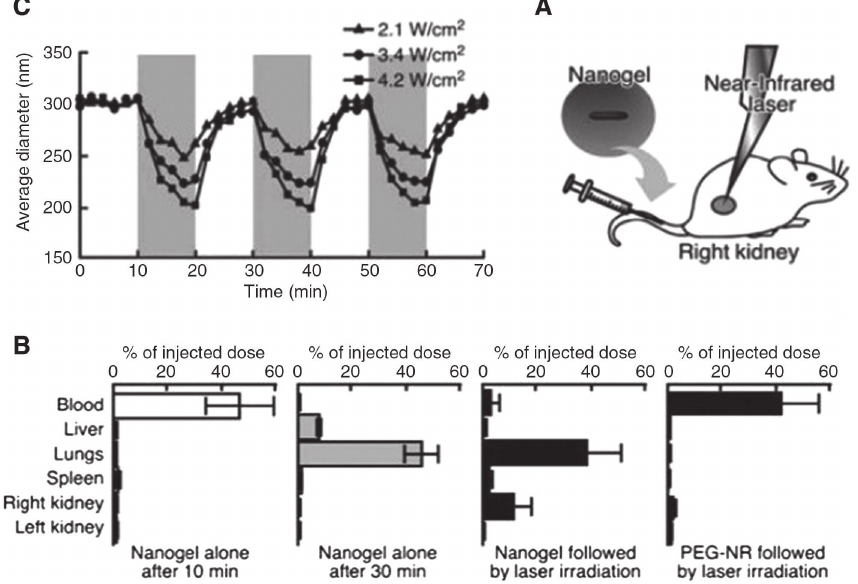
Figure 10: (A) A scheme showing the administration of the gold-hydrogel particle nanocomposites followed by near-IR light irradiation. (B) White and light-gray bars indicate the distribution after 10 and 30 min, respectively, when particle nanocomposites were injected with no irradiation. The black bars indicate the distribution when nanocomposites are injected followed by laser irradiation. The last dia- gram indicates the injection of polyethylene glycol (PEG)-modified gold nanorods and laser irradiation. (C) The hydrodynamic diameters of PNIPAAm-coated gold nanorods upon irradiation using a near-IR laser with increasing power density. The periods of laser irradiation are indicated by the gray area. Reproduced from Ref. [25] with the permission of The Royal Society of